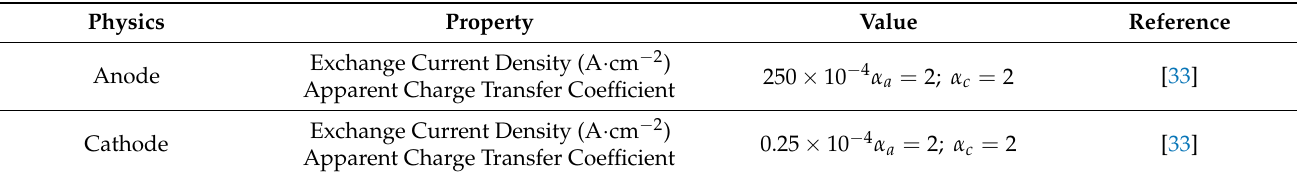
Table 3. Parameters of the electrochemical reactions.